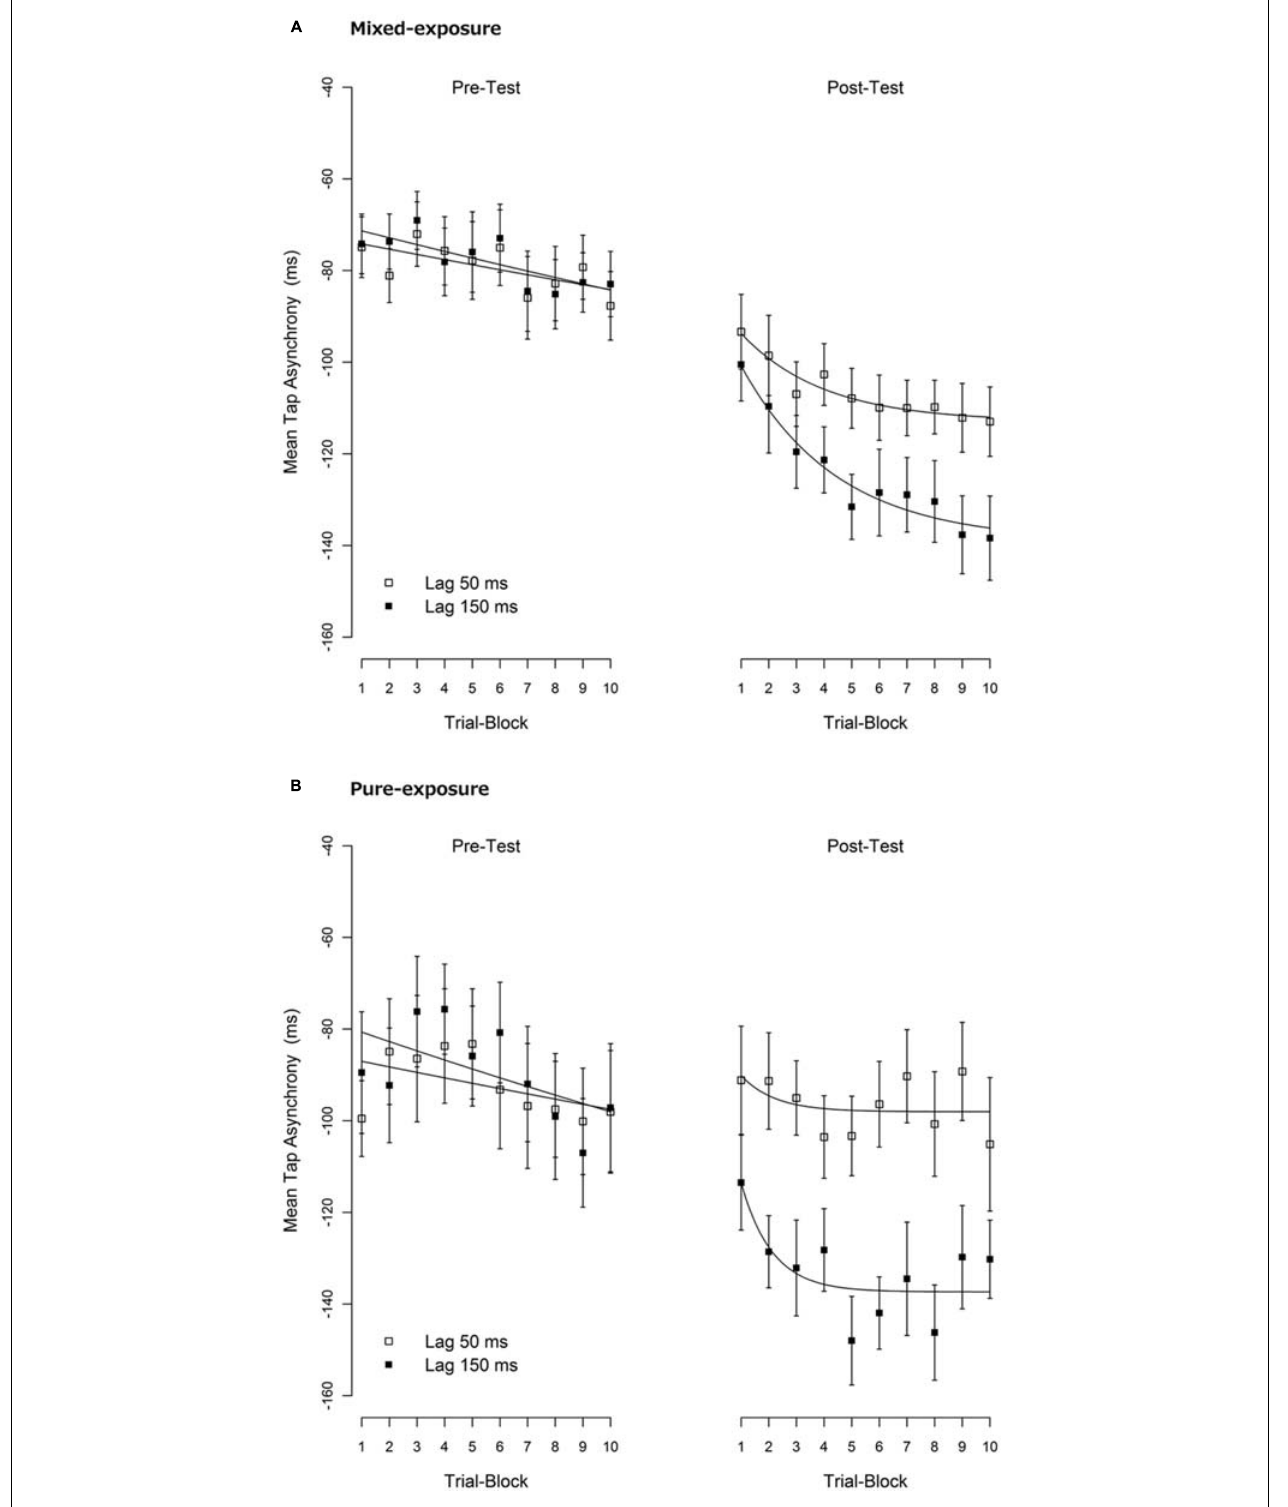
FIGURE 3 | Mean tap asynchronies per trial-block. (A) The mixed- exposure condition. (B) The pure-exposure condition. One trial-block contains two consecutive trials. A negative tap-asynchrony means that the tap comes before the tone (i.e., an anticipation error). Error bars represent 1 standard